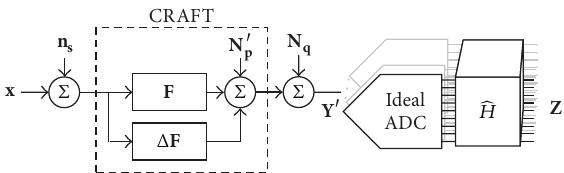
Figure17:AnLTImodelofthenonidealCRAFToperationfollowed by digitization and